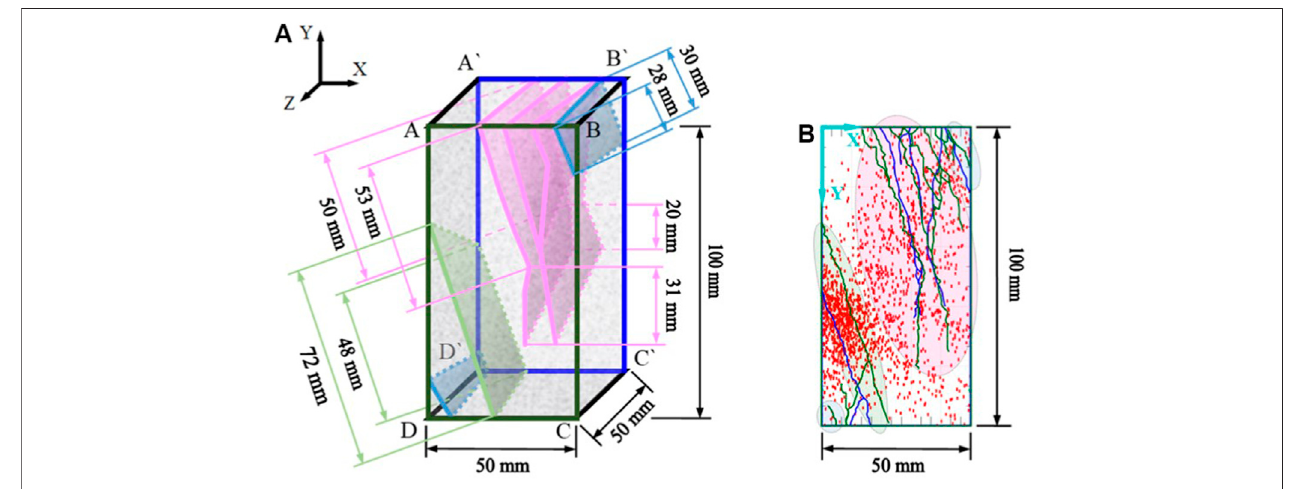
FIGURE 12 | Display of the three-dimensional crack failure morphology of tested granite under true triaxial stress state. (A) 3-dimensional failure morphology and (B) 2-dimensional failure morphology.